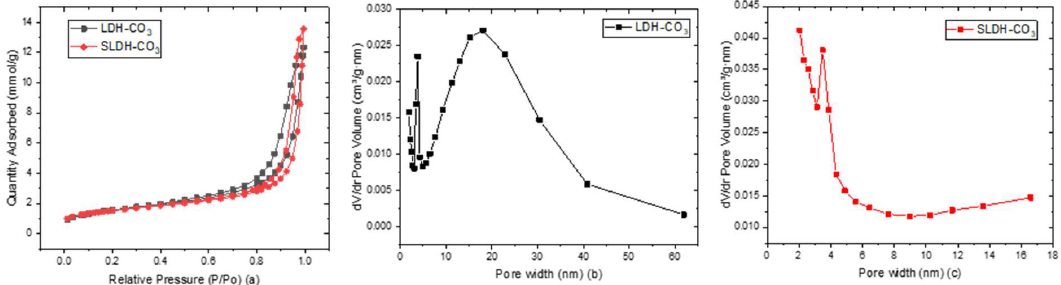
Figure 4. Nitrogen adsorption / desorption isotherms of the ochre derived LDH-CO 3 and metal salt SLDH-CO 3 ( a ). Pore size distribution curves of the LDH-CO 3 ( b ) and SLDH-CO 3 ( c ). Regarding the Barrett–Joyner–Halenda (BHJ) method, both samples were separated in two different plots.